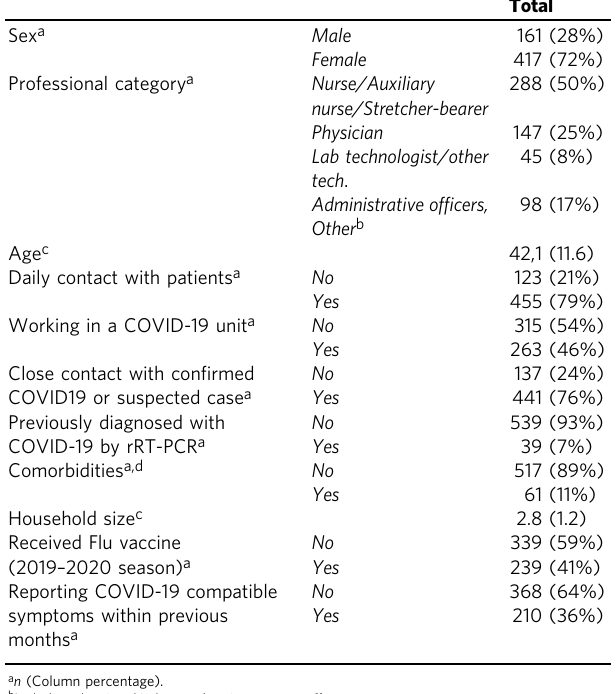
Table 1 Baseline characteristics of study